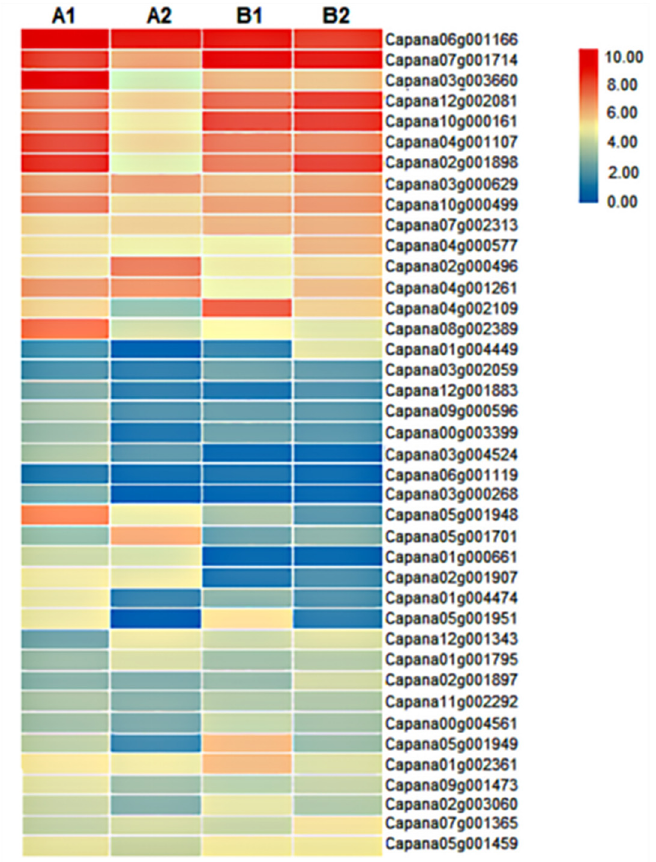
Figure 7. Heat map analysis of ERFs. Annotation: Different colors represent different FPKM values; red represents higher FPKM values, and blue represents lower FPKM values.